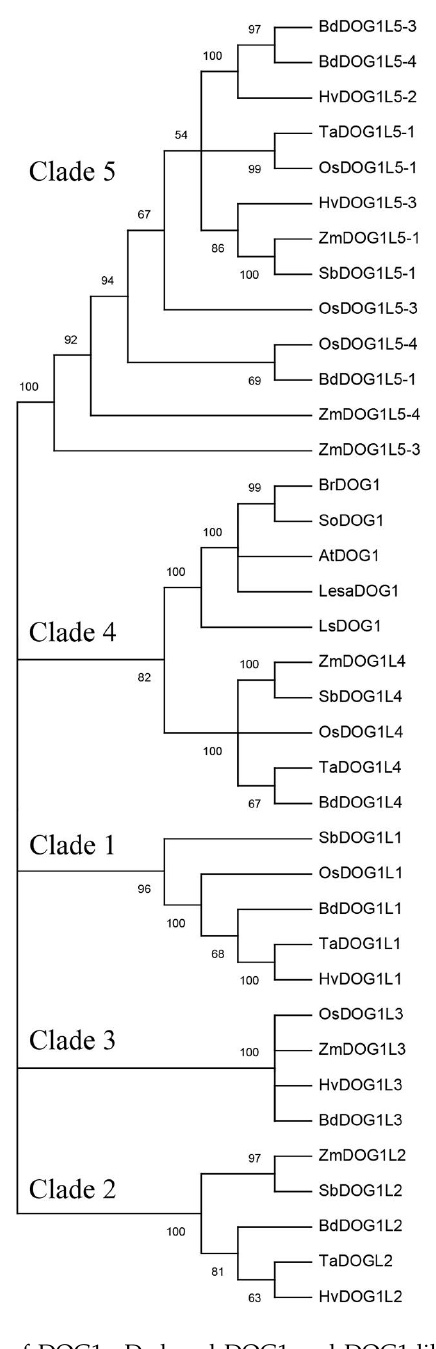
Figure 1. Phylogenetic tree of DOG1. Deduced DOG1 and DOG1-like amino acid sequences of Arabidopsis thaliana (AtDOG1, AtDOGL1-5); deduced DOG1 amino acid sequences of Brassica rapa (BrDOG1), Lactuca sativa (LsDOG1), Lepidum sativum (LesaDOG1), Sisymbrium o ffi cinale (SoDOG1); and the homologs in cereals Brachypodium distachyon (BdDOG1L1 to L5), Hordeum vulgare (HvDOG1L1, L2, L3, and L5), Oryza sativa (OsDOG1L1, L3, L4, and L5), Sorghum bicolor (SbDOG1L1 to L5), Triticum aestivum (TaDOG1L1, L2, L4, and L5), and Zea mays (ZmDOG1L2 to L5) were included. Tree